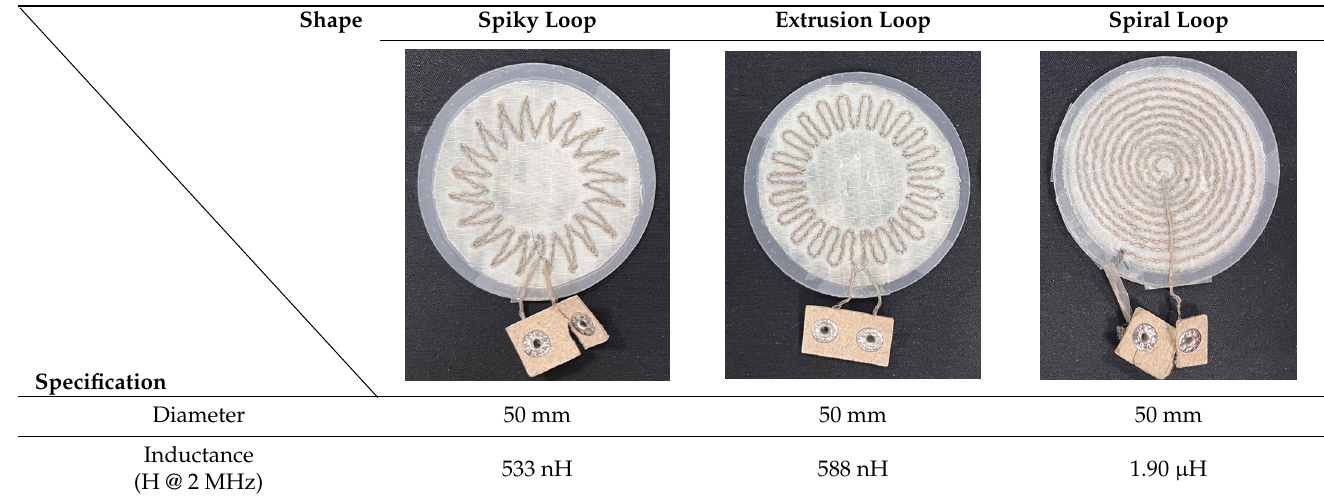
Table 1. Shapes and specifications of the three types of fabric loop sensors.